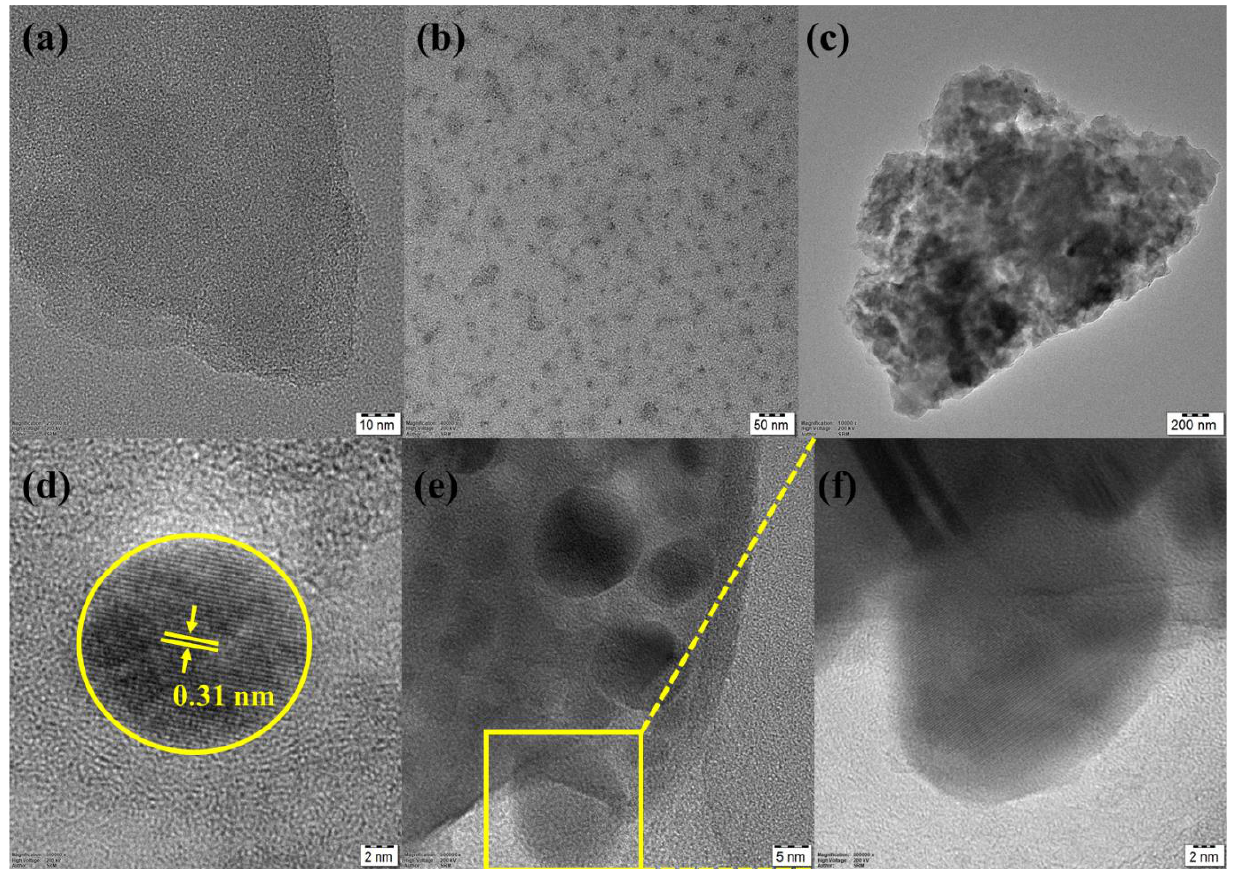
Figure 3. TEM images of ( a ) CN, ( b ) CDs, ( c ) 3CDCN, HR-TEM of ( d ) CDs, ( e ) 3CDCN at a 5 nm scale, and ( f ) 3CDCN at a 2 nm scale.